Question: Which visualization type does this figure use?
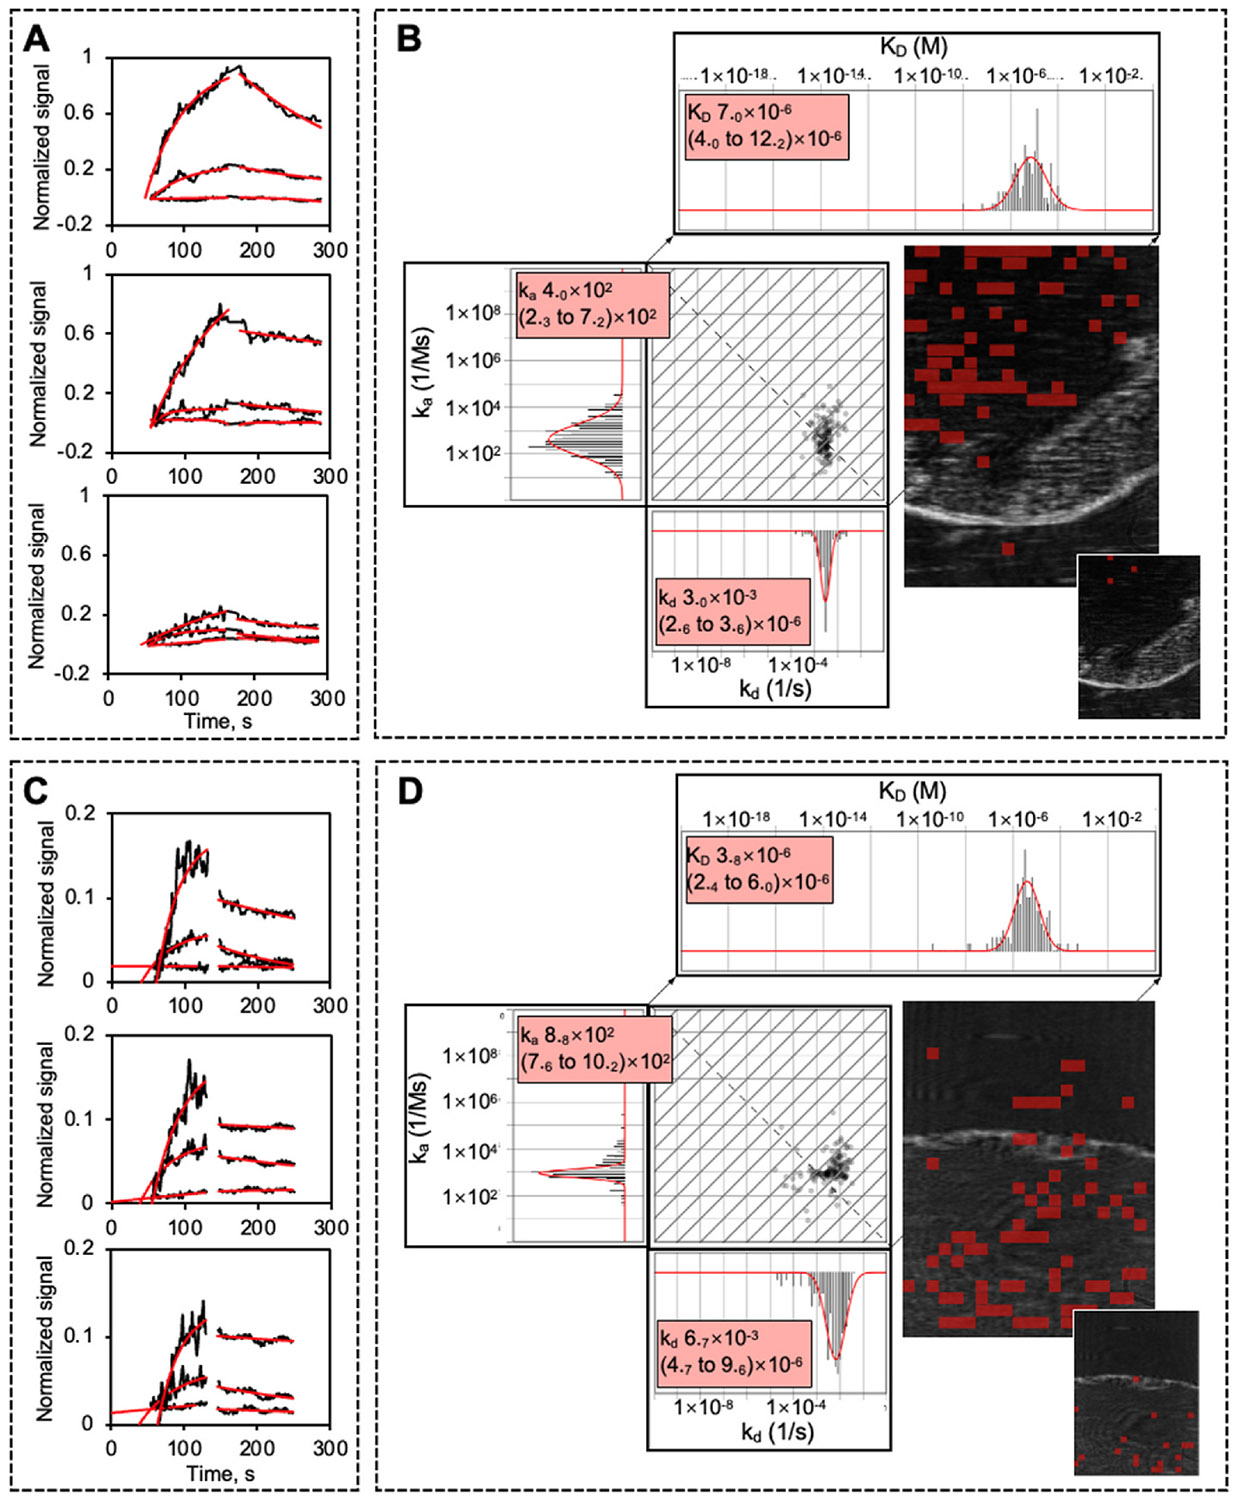
Answer: scatter